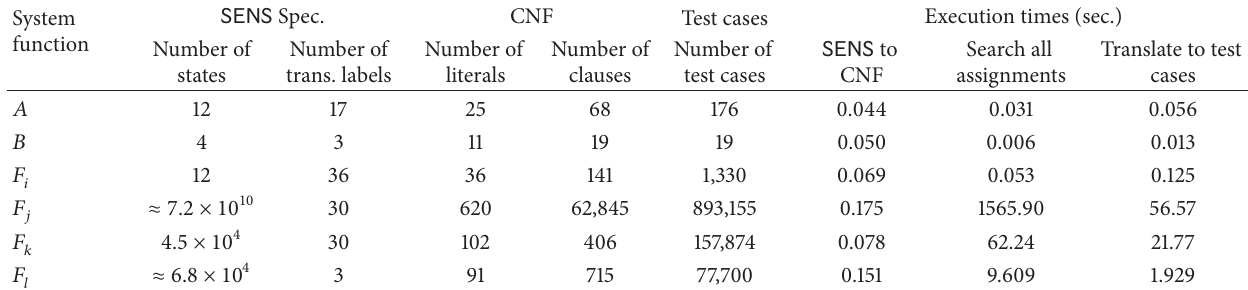
Table 3: Experiment results for test case generation.